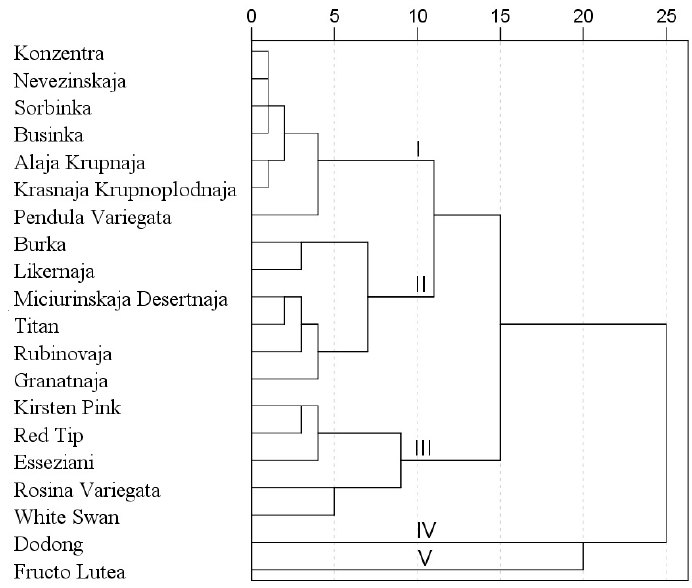
Figure 4. Dendrogram of the similarity of Sorbus fruit powder samples according to their phytochemical